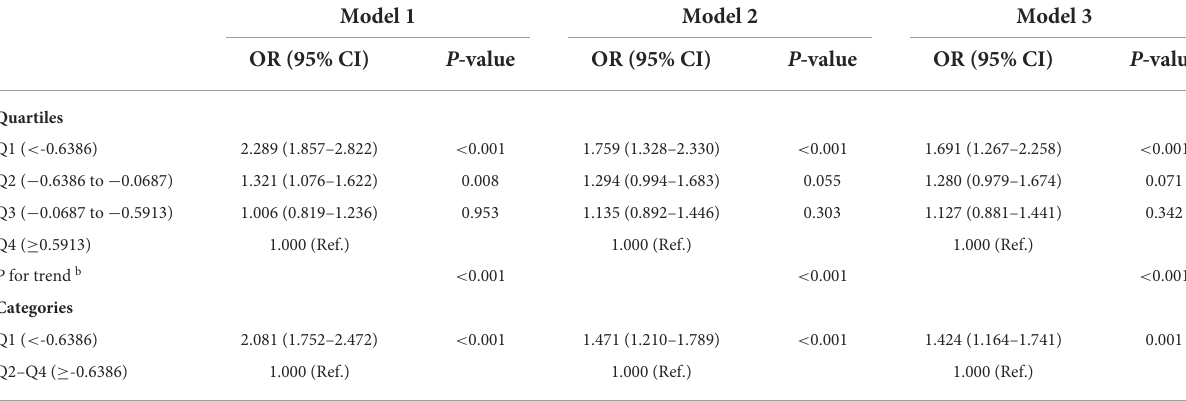
TABLE 2 Odds ratios (ORs) and 95% confidence intervals (CIs) for the relationship between composite pulmonary function and MCI a .